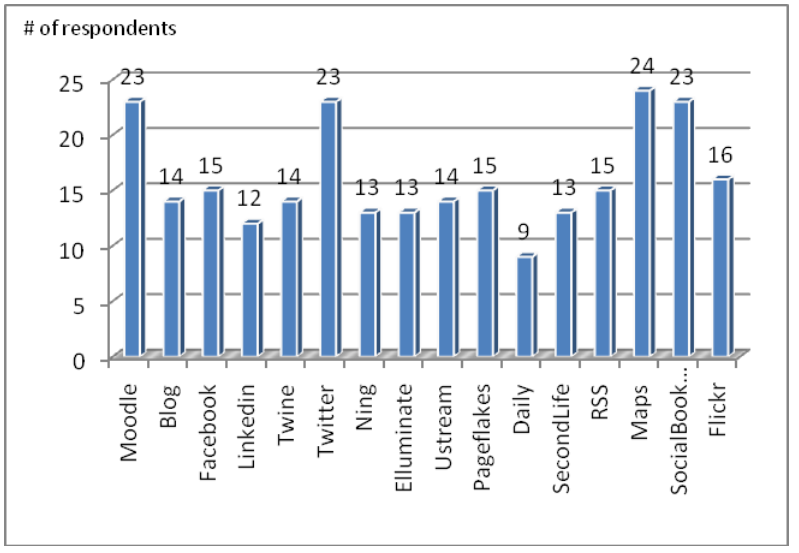
Figure 12. Frequency of neutral or